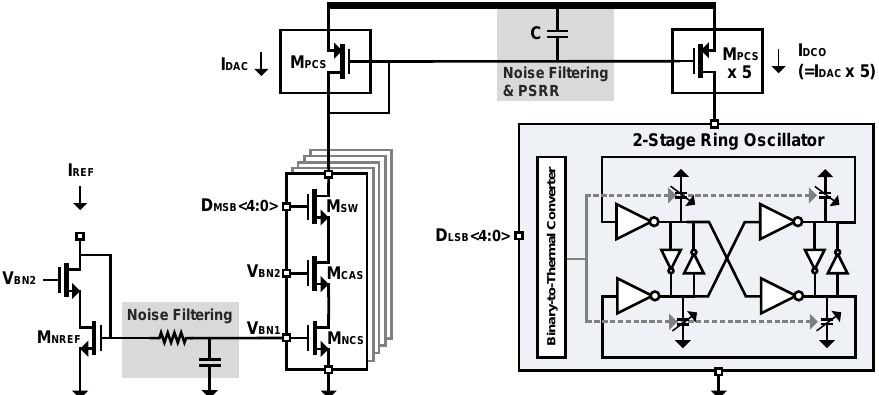
Figure 12. The DCO architecture that consists of a current-steering DAC and a 2-stage ring oscillator with thermometer-coded capacitor